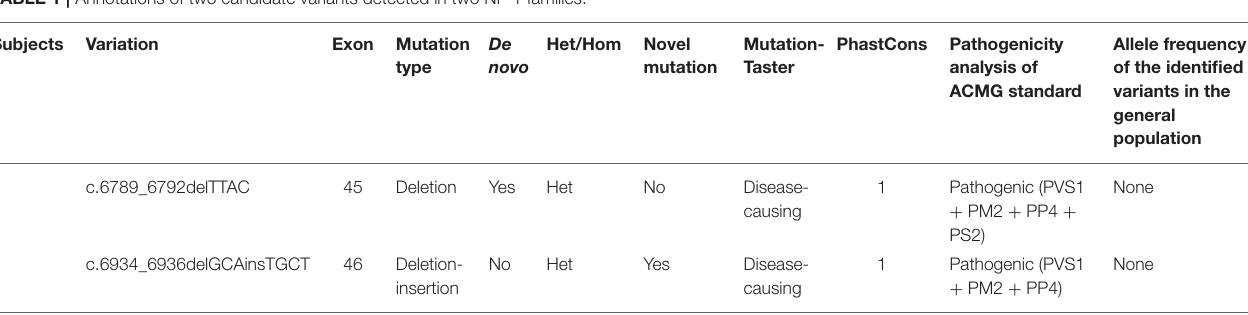
TABLE 1 | Annotations of two candidate variants detected in two NF-1